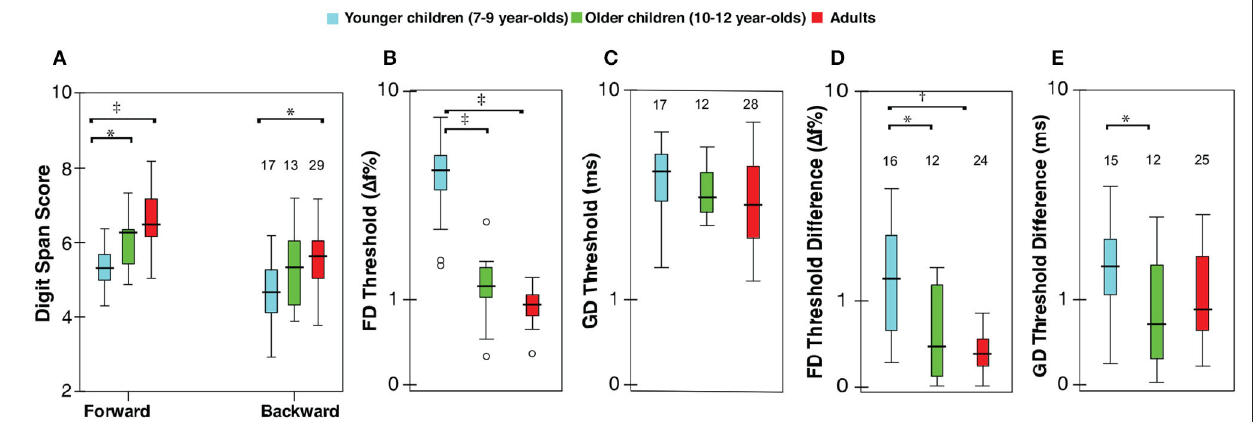
FIGURE 1 | Box-Whisker plots showing (A) digit span scores (for forward and backward span), (B) frequency discrimination (FD) thresholds, expressed as a percent of the standard frequency (1,000Hz), (C) gap detection (GD) thresholds (ms), test-retest differences for (D) FD, and (E) GD thresholds; ordinate is (safe 1 ) log-scaled for all but digit span. Horizontal lines indicate the median, boxes span from the 25th to 75th percentile, and whiskers show the maximum and minimum values. Separate data points are outliers. The numbers on top show the included data and were same for FD and GD thresholds. Significant differences between groups are indicated at the top part of the figure (* p < 0.05, † p < 0.01, ‡ p <